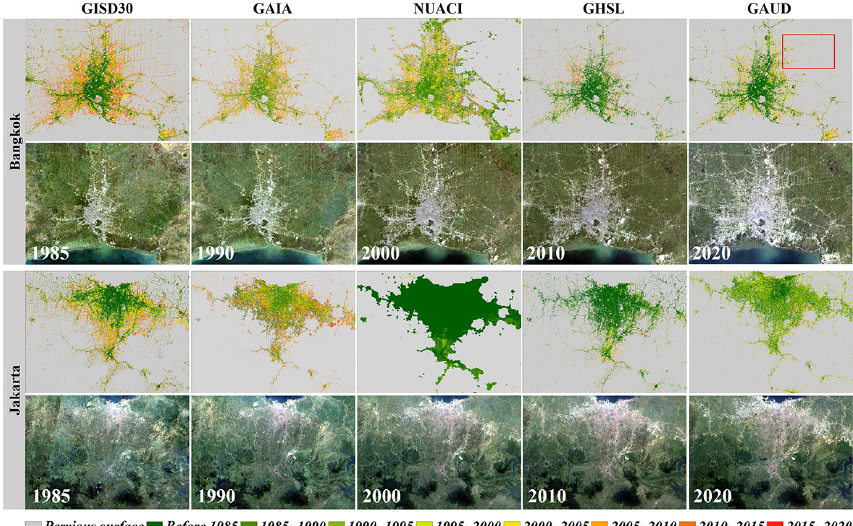
Figure 13. The comparisons between GISD30 and four reference datasets (the GAIA products developed by Gong et al., 2020; NUACI developed by Liu et al., 2018; GHSL developed by Florczyk et al., 2019; and GAUD developed by X. Liu et al., 2020) in the two cloud- contaminated cities of Bangkok and Jakarta. In each case, the multi-epoch Landsat imagery, comprised of red, green and blue bands, came from the United States Geological Survey